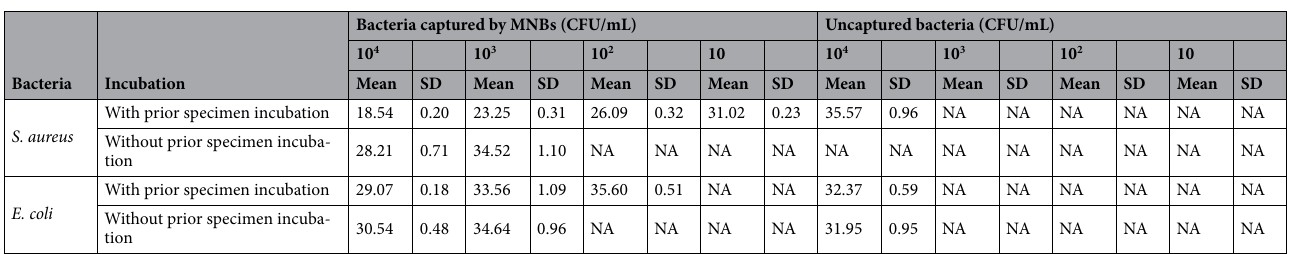
Table 1. Results of real-time PCR analyses. CFU, colony forming unit; SD, Standard deviation; NA, not